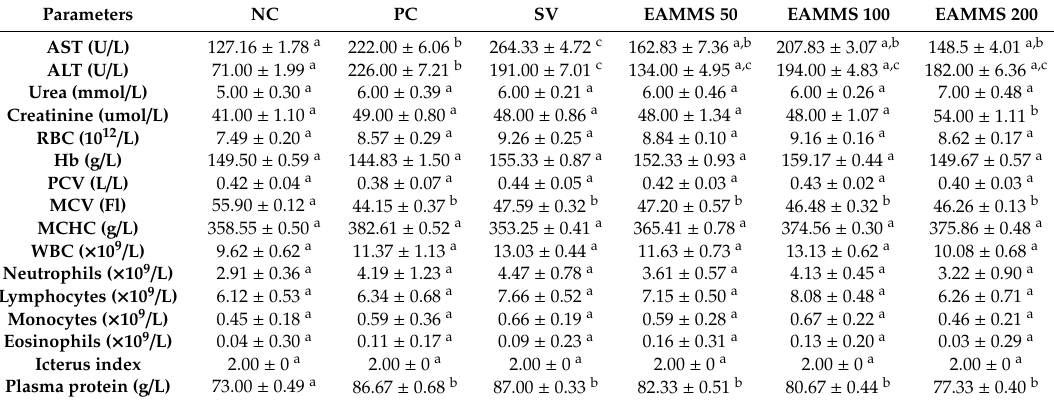
Table 2. Liver, kidney and haematology values of rats after treated with EAMMS extracts (week